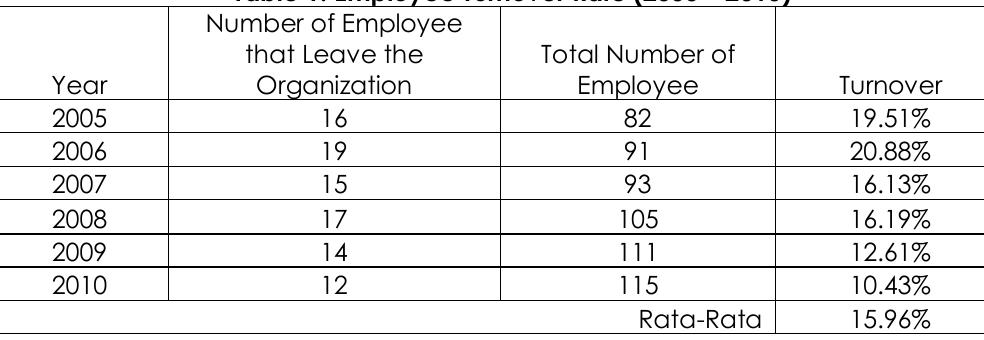
Table 1. Employee Turnover Rate (2005 –